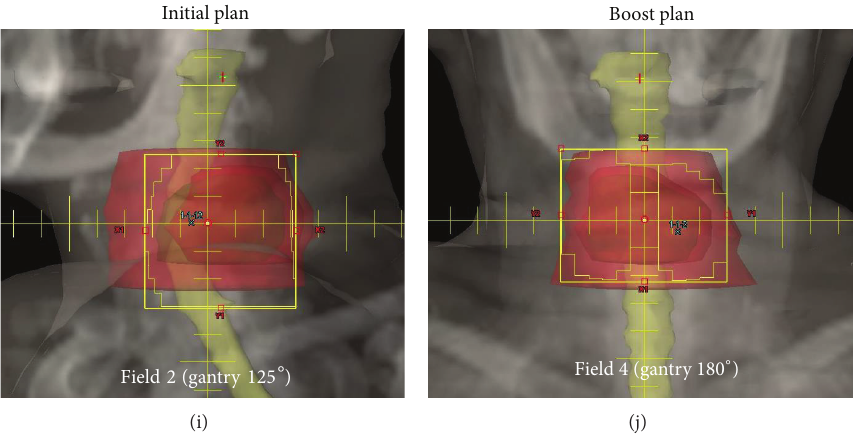
Figure 2: Target definitions, beam arrangements, and dose distributions for initial (left) and boost (right) plans. Beam arrangements (a), (b); dose distributions ((c), (d): axial; (e), (f): sagittal views); and beam’s eye views (g)–(j) for some representative fields. IDS isodose line.